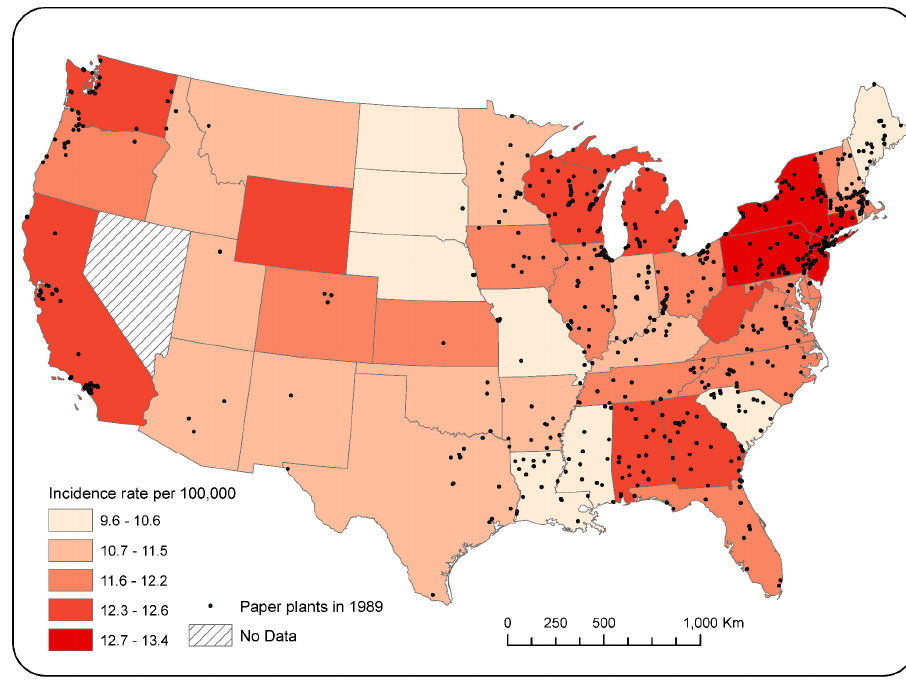
Figure 3. Paper mill locations and state ‐ level ovarian cancer incidence rates by state (2009–2013).